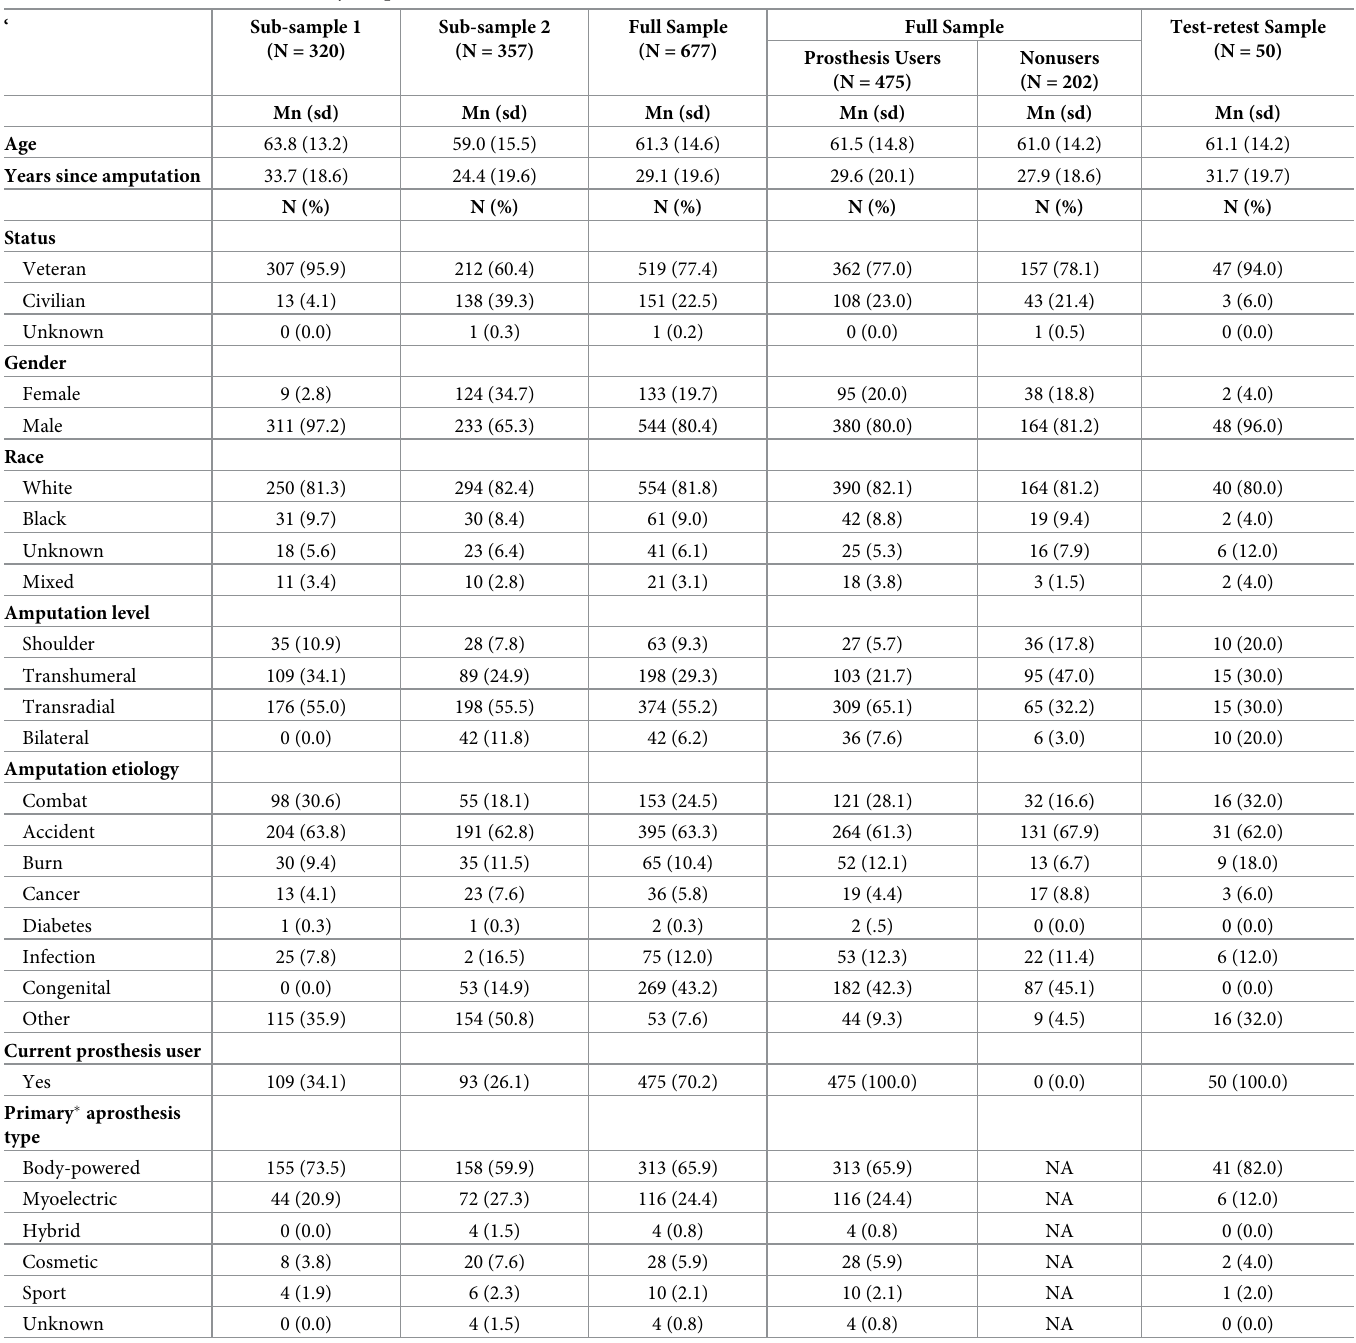
Table 2. Characteristics of the field study